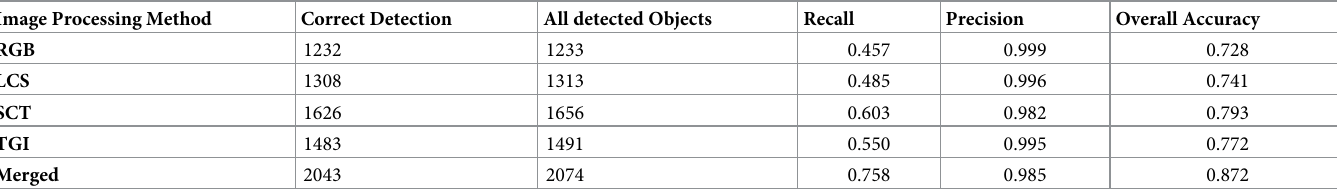
Table 6. Detection performance on ROI of 60m altitude variant. Image Processing